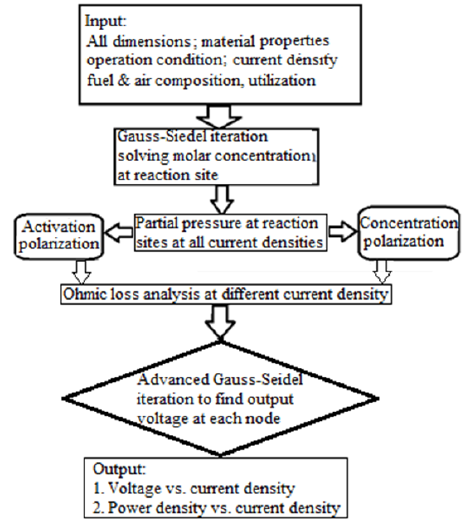
Figure 3. Computational procedures for simulation of proton-conductive solid oxide fuel